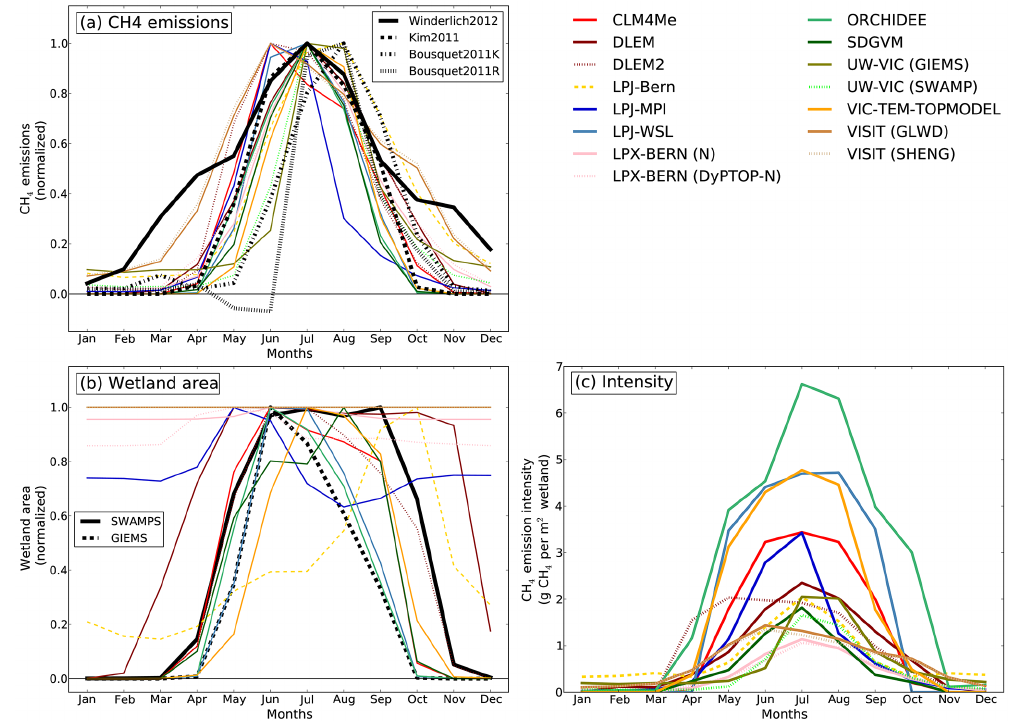
Figure 8. Average whole-domain seasonal cycles (1993–2004) of normalized monthly CH 4 emissions (top), normalized monthly CH 4 - producing or surface water areas (lower left), and monthly intensities (gCH 4 m − 2 of wetland area; lower right), with satellite surface water products and inversions for reference. CH 4 emissions and areas have been normalized relative to their peak